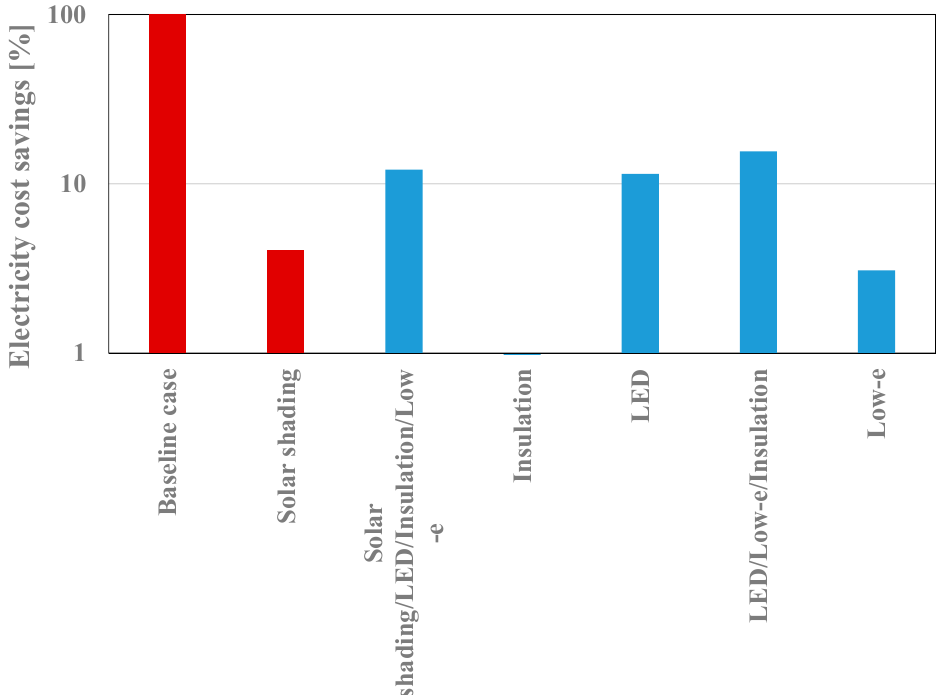
Figure 17. Cost energy savings of each retrofit intervention. The red color indicates negative savings, while the blue indicates positive savings.